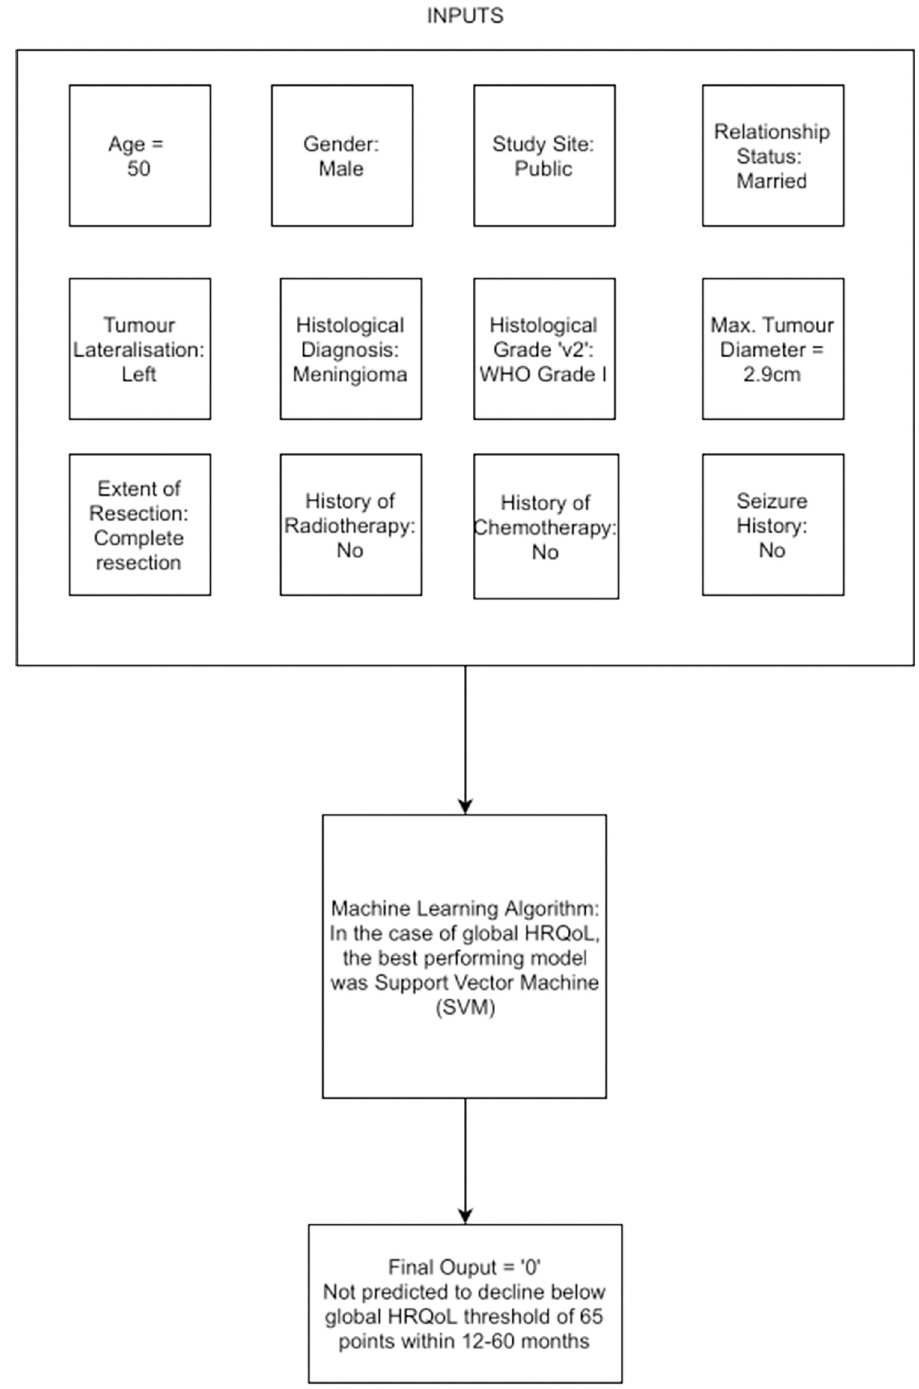
Fig 4. Worked example of ML model for global HRQoL. Twelve demographic and perioperative data inputs are used by the Support Vector Machine to predict whether global HRQoL will decline below the normative population mean (4) within 12–60 months of tumour